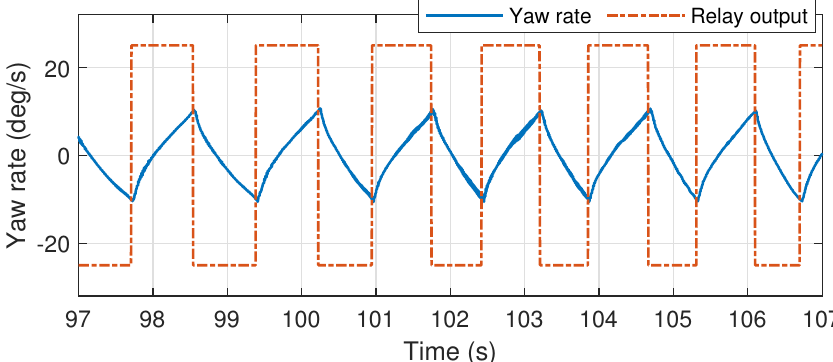
Figure 11. Inner loop relay feedback experiment for yaw axis.